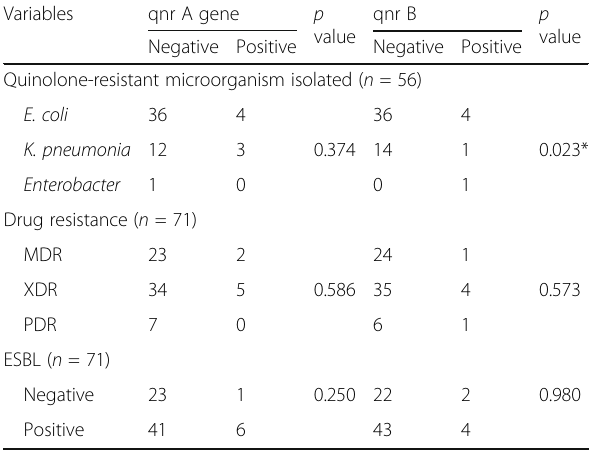
Table 4 Relationship of quinolone- and fluoroquinolone-resistant Enterobacteriaceae, drug resistance and ESBL, and qnrA and qnr B genes